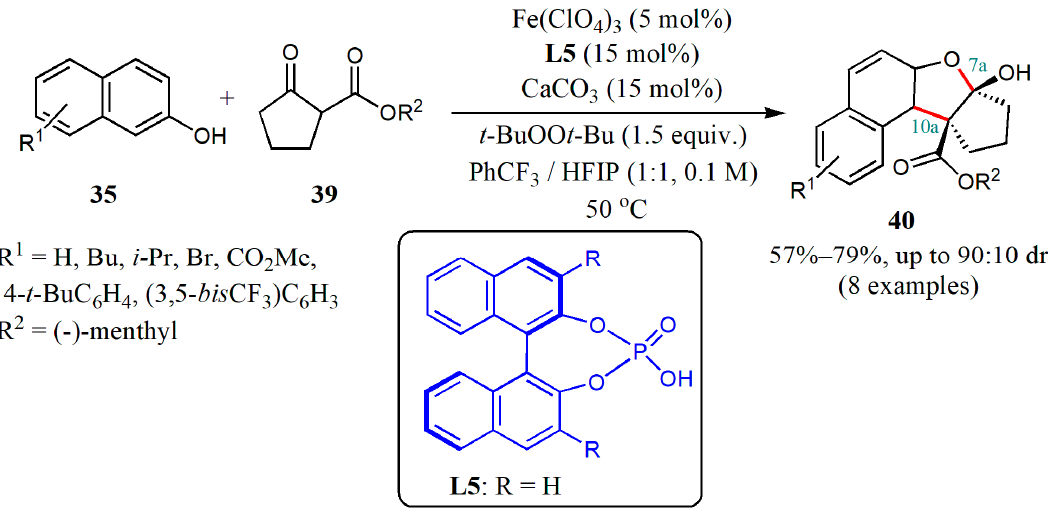
Figure 13. Iron-catalyzed asymmetric CDC of 2-naphthols with β -ketoesters.